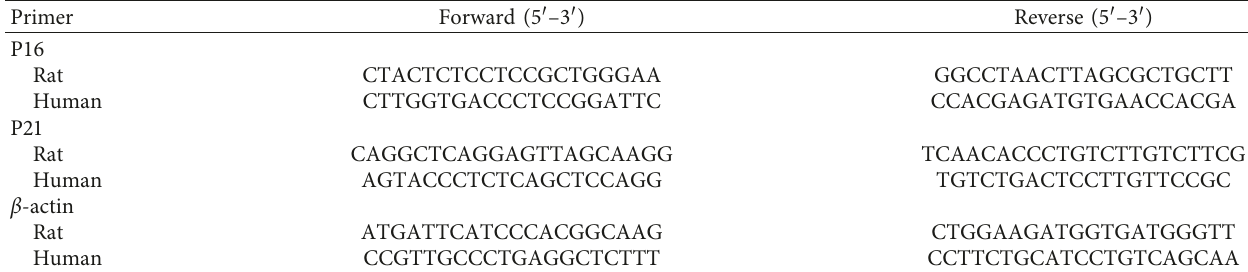
Table 2: The sequences of PCR primers used in this